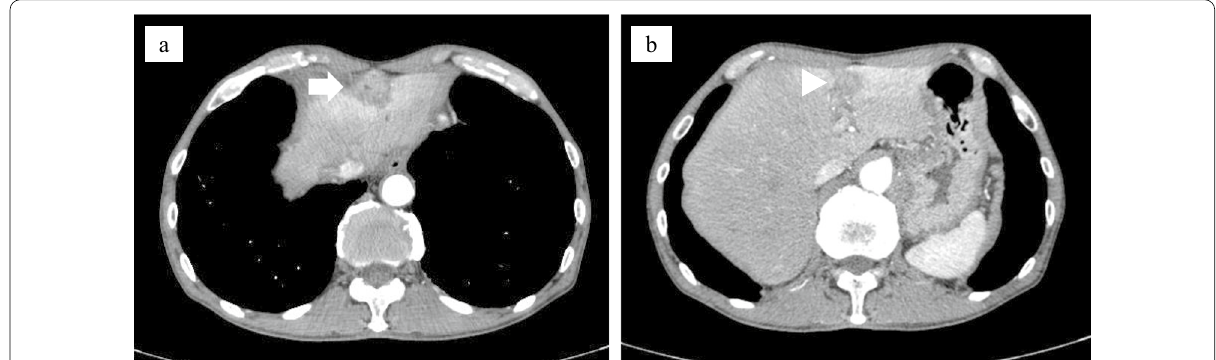
Fig. 3 Computed tomography a month following the first discharge. a The falciform ligament mass (white arrow) had increased in size, and the border between the mass and the liver was obscure. b A low-density nodule had emerged in liver segment three (white arrowhead)